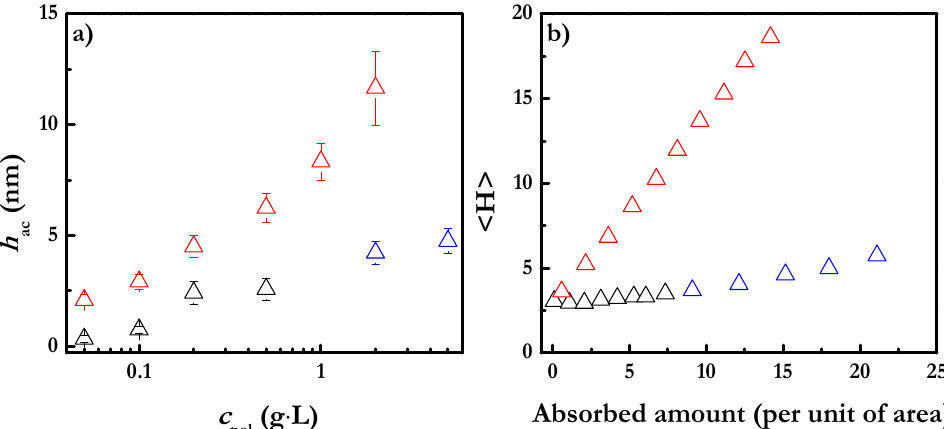
Figure 3. ( a ) Relationship between the hydrodynamic thicknesses of polyelectrolyte layers (PDADMAC, JR400 and CHI) deposited onto a negatively charged surface and polymer concentration (PDADMAC ( ∆ ), JR400 ( ∆ ) and CHI ( ∆ )). ( b ) Relationship between < H > and adsorbed amount (i.e., concentration in the solution) of the average film thickness obtained from SCF calculations for polyelectrolyte layers (PDADMAC ( ∆ ), JR400 ( ∆ ) and CHI ( ∆ )) deposited onto a negatively charged surface. Experiments and calculations were performed using solutions with a NaCl concentration of 100 mM. Note that the reported thicknesses correspond to those obtained after rinsing of the adsorbed layers with aqueous solutions with the same NaCl concentration contained in the polymer solutions used for the deposition.